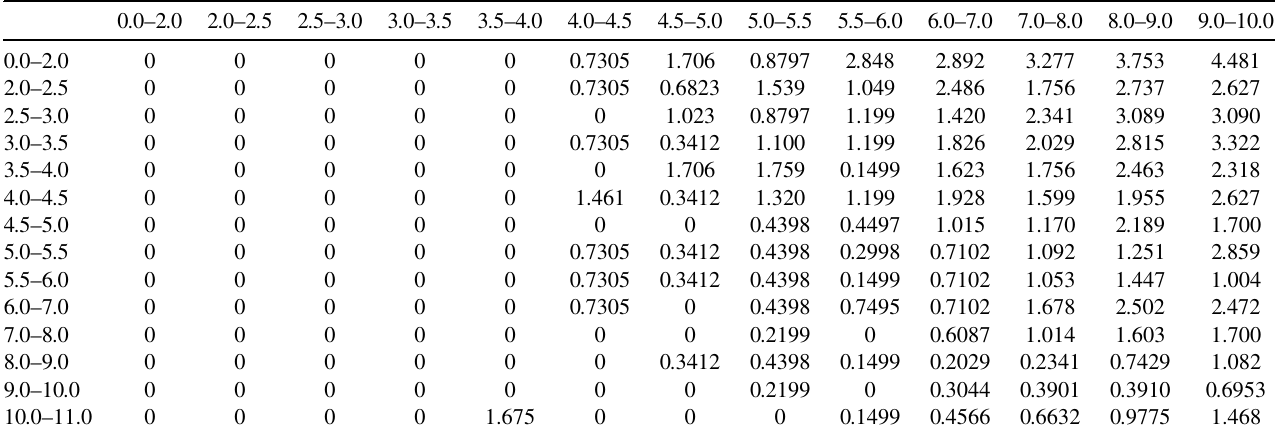
TABLE VIII. (cid:4) þ background from (cid:3) (cid:5) CC events (all values (cid:2) 10 (cid:1) 4 ).